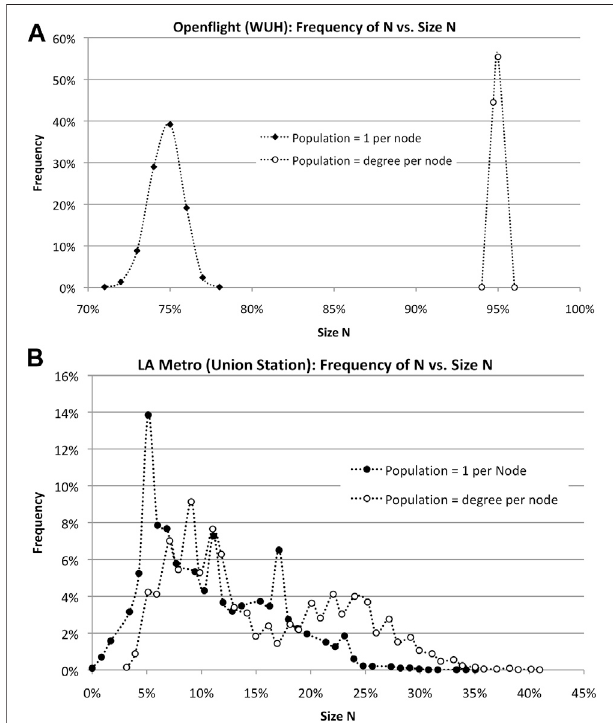
FIGURE 8 | Simulations of epidemics in travel networks Open fl ight and LA Metro show vast differences in peak N for different assumptions about population. (A) . Open fl ight size of outbreak N varies depending on the population at each node: one vs. the degree of the node. The horizontal axis is the percentage of the total number of nodes. (B) . LA Metro size of outbreakNvariesdependingonthepopulationateachnode:1vs.thedegree of the node. In addition, the topology of the network – low clustering – vastly reduces the size N. Infection rate v (cid:1)